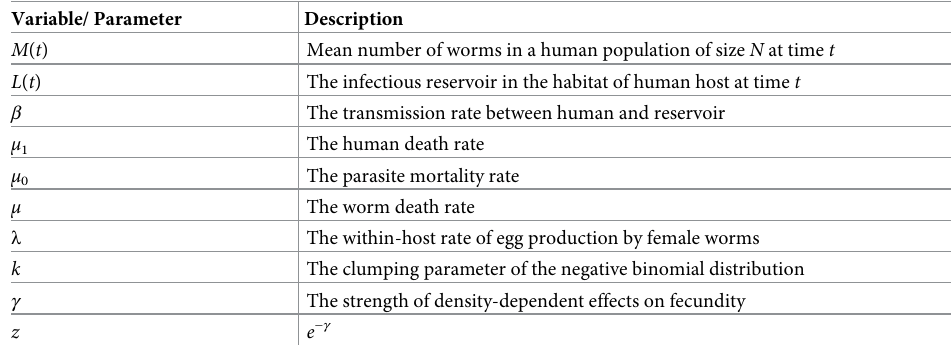
Table 1. Variables and parameters in model